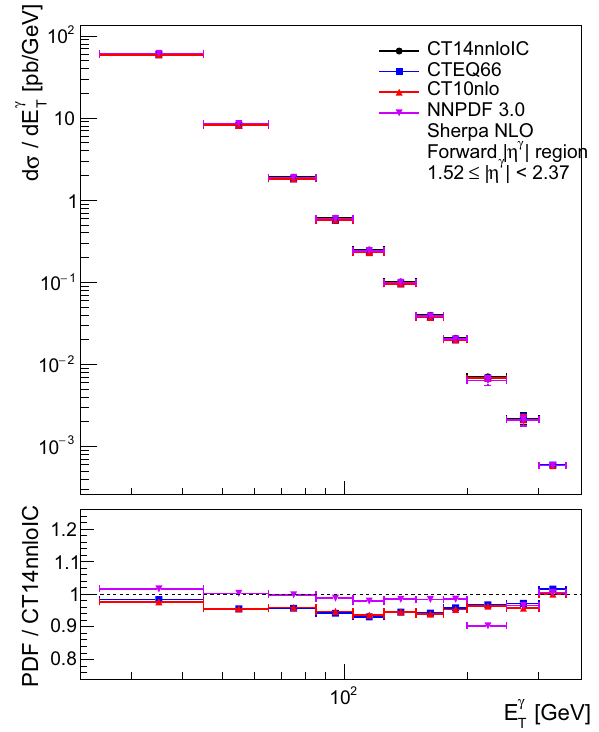
γ Fig. 6 Top: The E spectrum of photon in the forward rapidity T region and with zero IC contribution using different PDFs, namely, CT14nnloIC (black points), CTEQ66 (blue points), CT10 (red points), NNPDF (lilac points). Bottom: the ratio of different PDFs to the CT14nnloIC central set